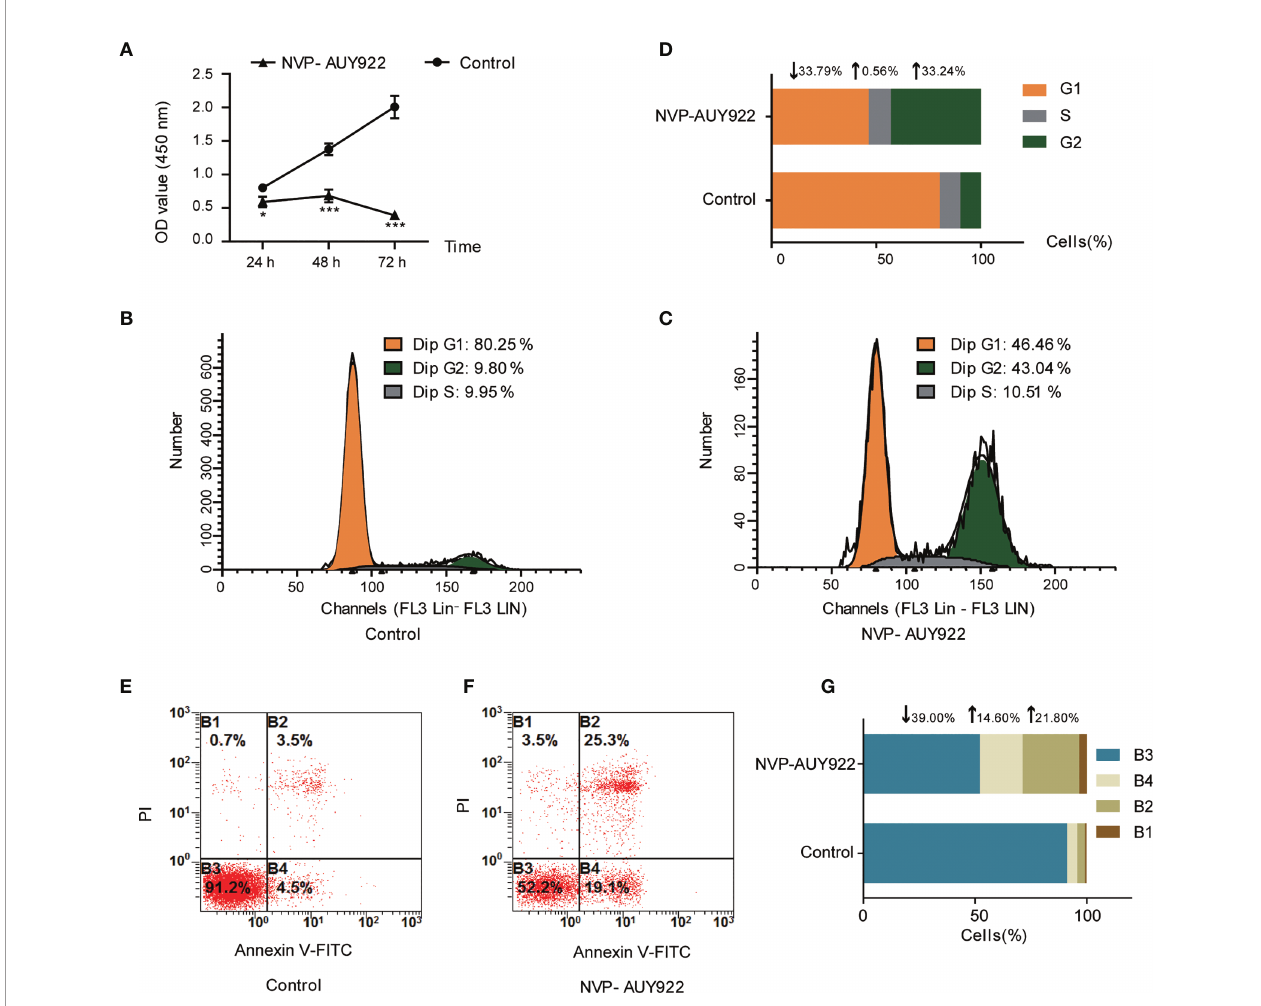
FIGURE 1 | Cell inhibition activity of NVP-AUY922 on NSCLC cell line H1299. (A) NVP-AUY922 inhibited H1299 cell viability. NVP-AUY922 signi fi cantly suppressed cell viability against H1299 and its inhibition activity increased with elongated treat time. The data was presented as Mean ± SD, * P < 0.05, *** P < 0.001 ( vs Control, n = 3) indicated a signi fi cant difference versus the control. (B) Cell cycle distribution for H1299 treated with DMSO for 72 h. (C) Cell cycle distribution for H1299 treated with NVP-AUY922 for 72 h. (D) Bar graph for cell percentage in G1, S and G2 phase of H1299 treated with NVP-AUY922 or DMSO for 72 h NVP-AUY922 induced H1299 cell cycle arrest in G2 phase. (E) Cell distribution in four quadrants of H1299 treated with DMSO. (F) Cell distribution in four quadrants of H1299 treated with NVP-AUY922. (G) Bar graph for cell percentage in four quadrants of H1299 treated with NVP-AUY922 or DMSO. Control, H1299 treated with DMSO; NVP-AUY922, H1299 treated with NVP-AUY922. The four quadrants represented as: B1, necrotic cell rate; B2, late apoptotic rate; B3, Normal cell rate; B4, early apoptotic rate. NVP-AUY922 promoted H1299 cell apoptosis. The results indicated that NVP-AUY922 exhibited favorable inhibition activity against H1299 cells by suppressing cell viability, inducing cell cycle arrest and promoting cell